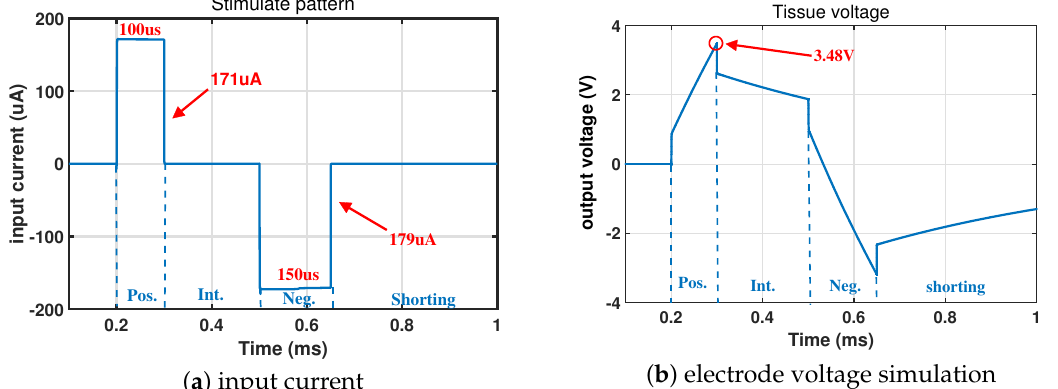
Figure 6. Simulation results of the electrode under the 6 nF working electrode capacitor C W and the 100 k Ω working electrode resistor R W . ( a ) An input current with the 188 µ A amplitude 011000 is applied; ( b ) the detected output voltage. Pos: positive, Neg: negative, Int. is the interval in Figure